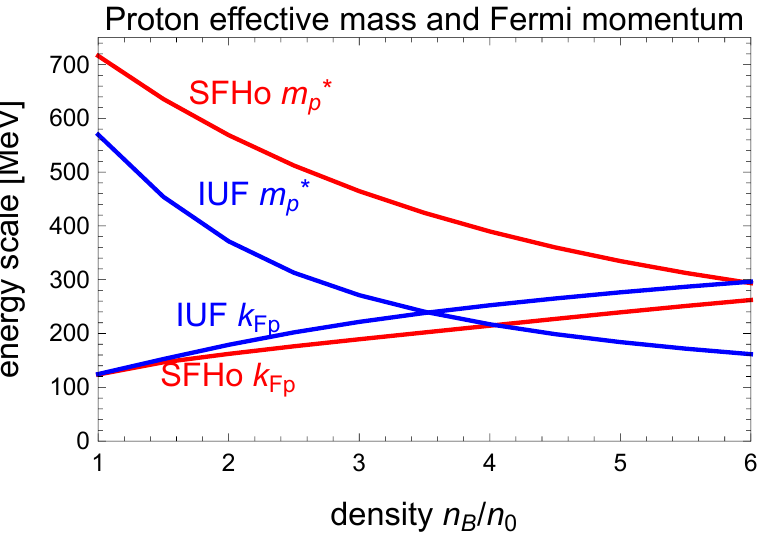
Figure 3. Density dependence of the proton’s (Dirac) effective mass and Fermi momentum for the IUF and SFHo EoSs, showing that protons at the Fermi surface become relativistic starting at densities between 3 − 6 n 0